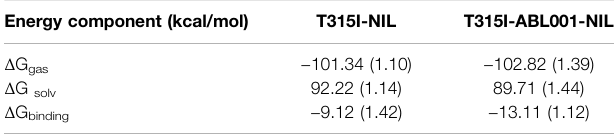
TABLE 1| Binding freeenergyanalysis(kcal/mol) for the interactions between NIL and T315I BCR-ABL1 in T315I-NIL system and T315I-ABL001-NILsystem a . Energy component